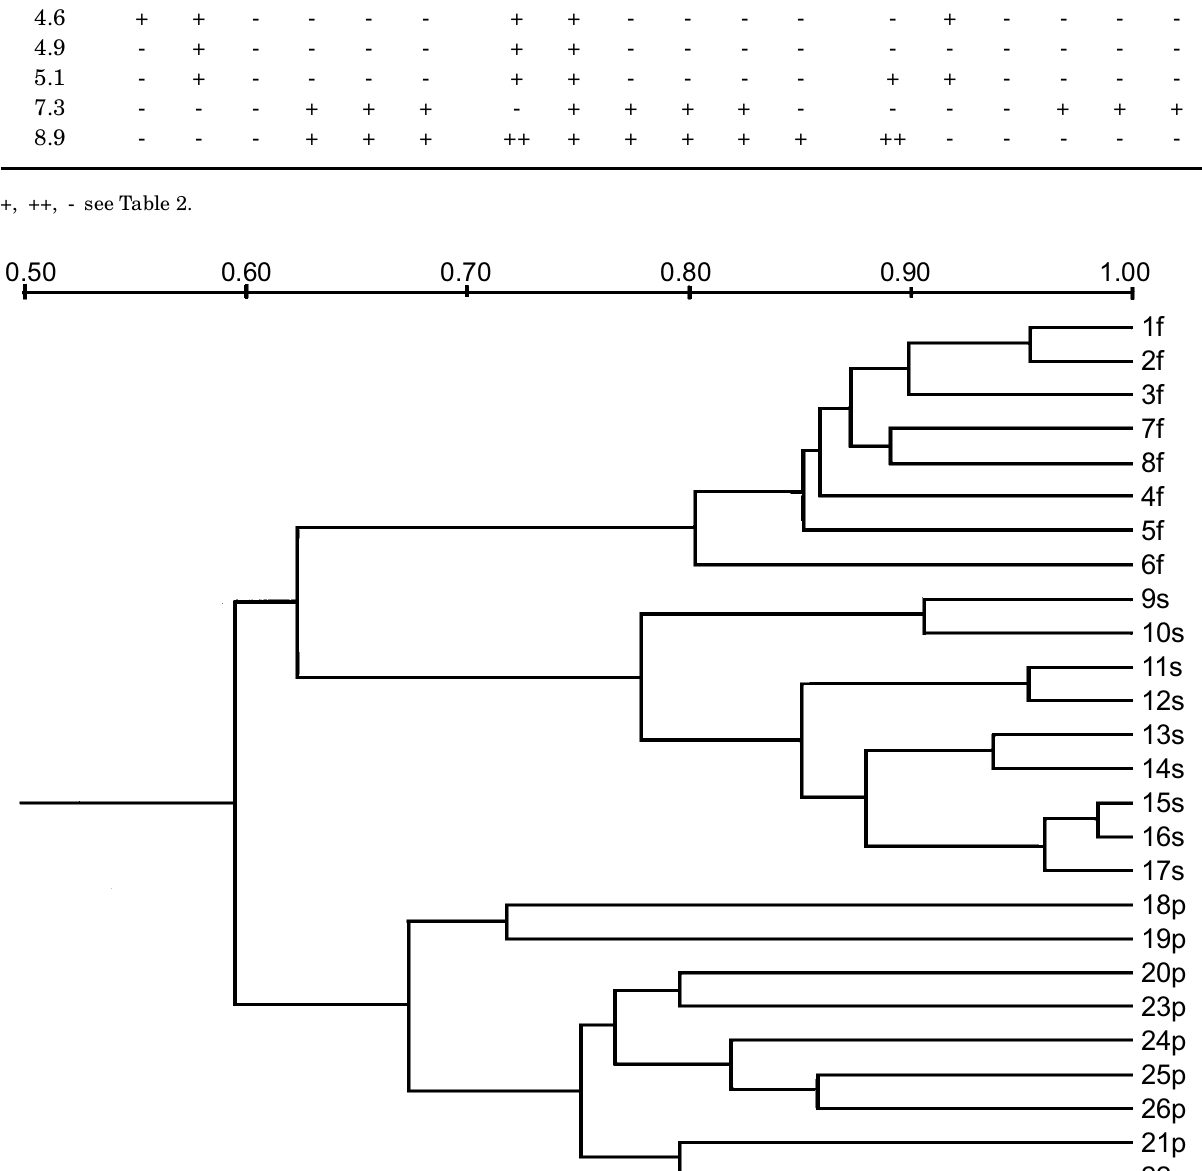
Fig. 6. UPGMA dendrogram based on all isozymes of polygalacturonase, pectin lyase and pectin methylesterase produced by the isolates belonging to the intersterile groups P, S and F of Heterobasidion annosum at 3, 6, 9, 13, 16 and 20 days of culture in a growth medium with pectin as the sole carbon